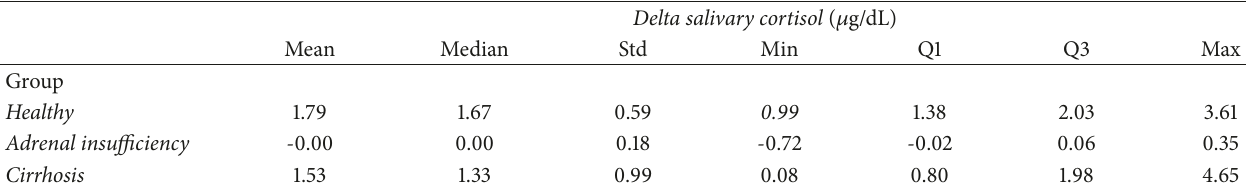
Table5:Changeinsalivarycortisolbetweenbaselineand60minutesinhealthyvolunteers,adrenalinsufficientpatients,andcirrhoticpatients in the 250 𝜇 g ACTH test.